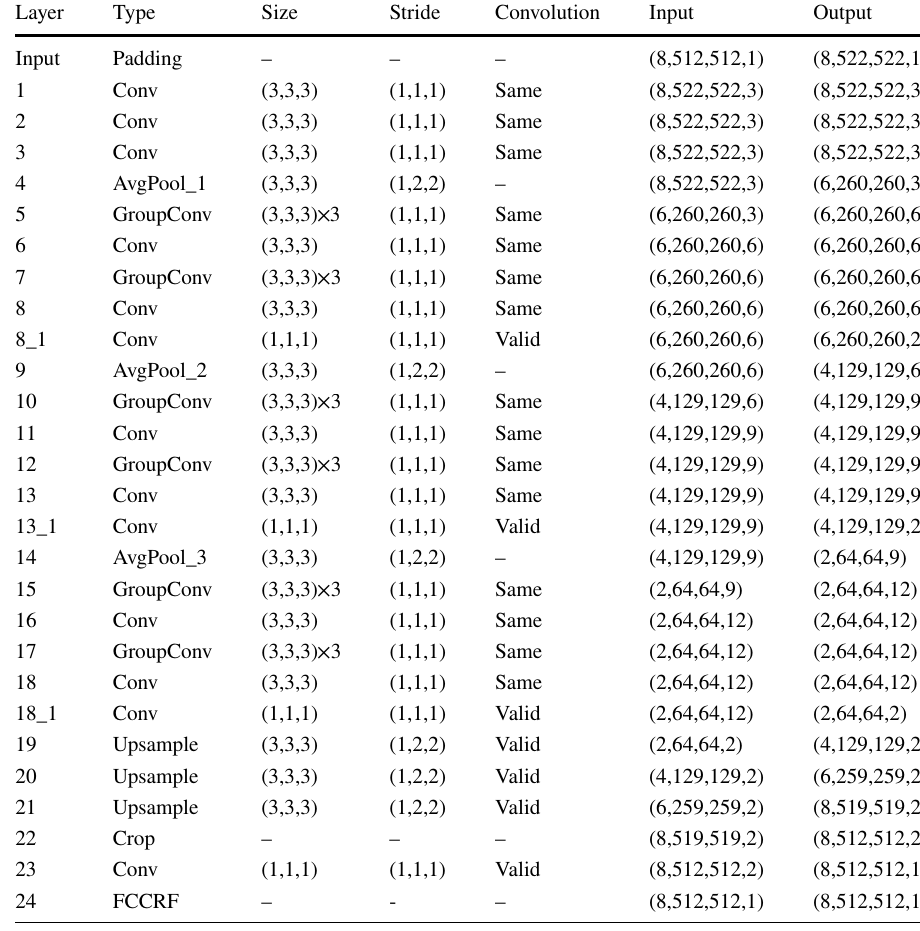
Table 2 3D-GFCN model structure parameters